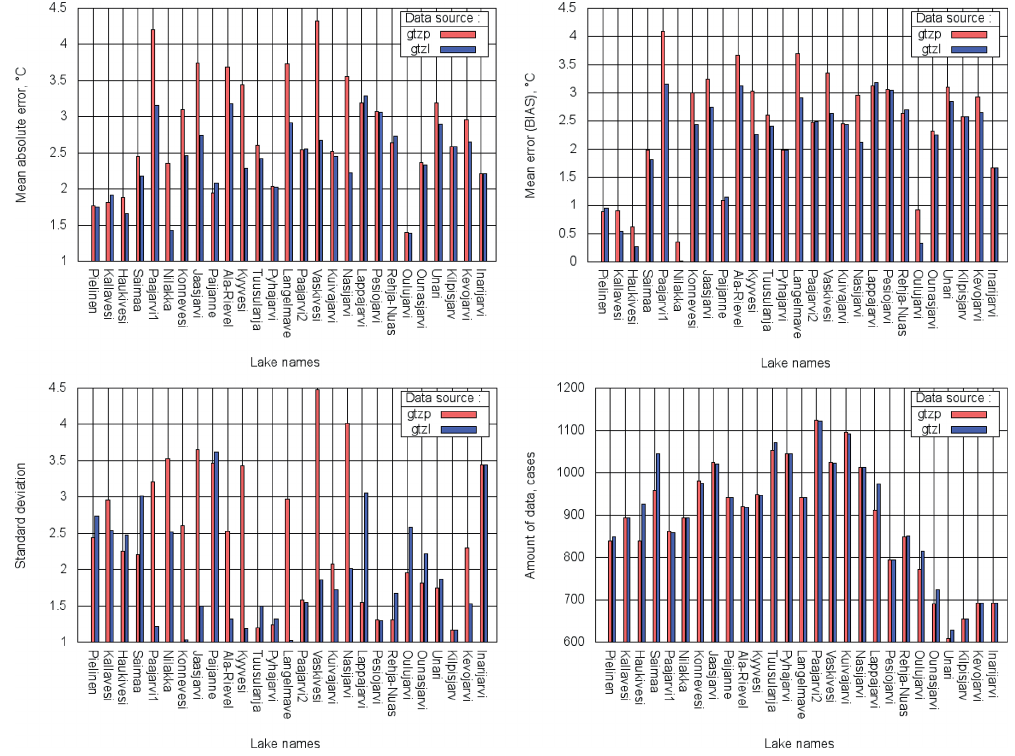
Figure 11. MAE, bias, SD and amount of data calculated over the total period of 2010–2014 for 27 verification sites; GTZP (red) – experiment with operational D water , GTZL (blue) – with upgraded D water